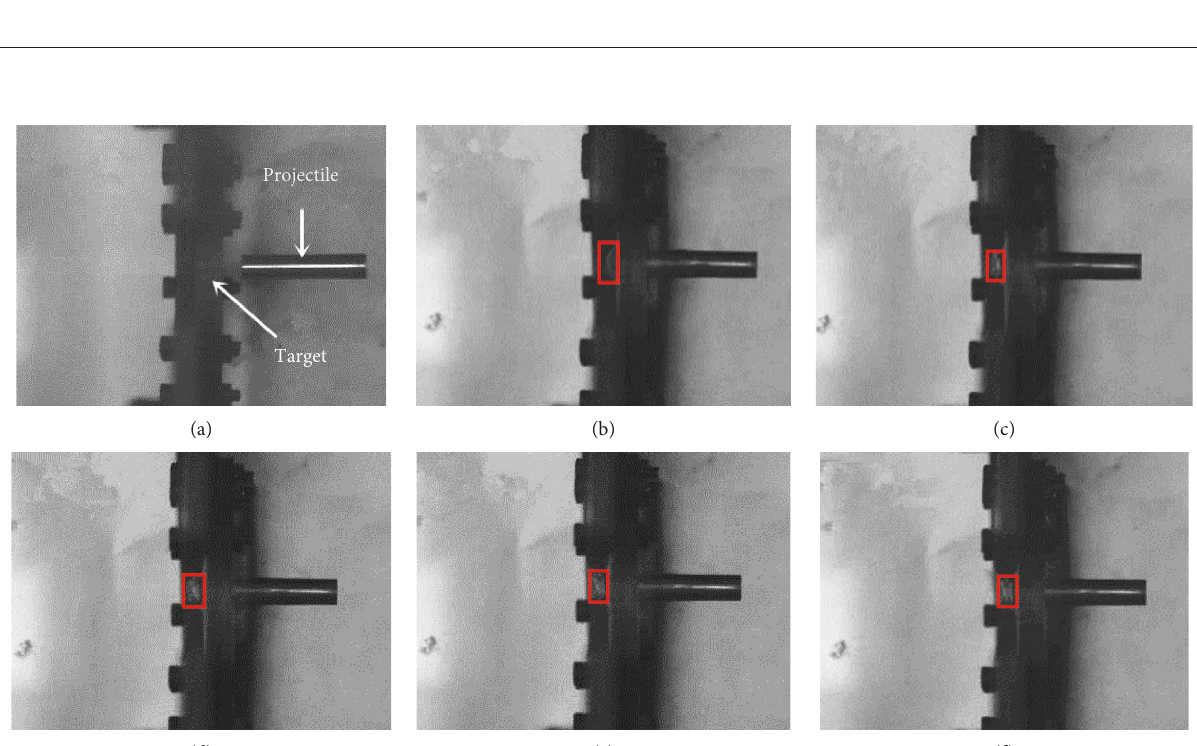
Figure 9: Penetration process of target plate under projectile impact at V